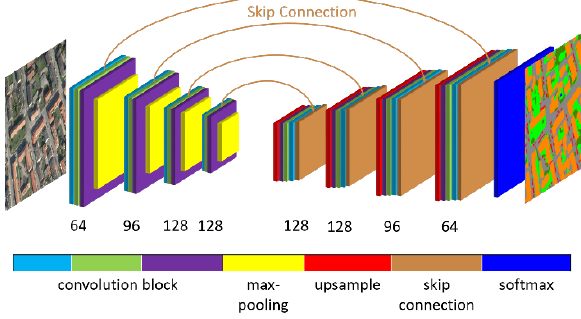
Figure 1. The architecture of SkipNet .